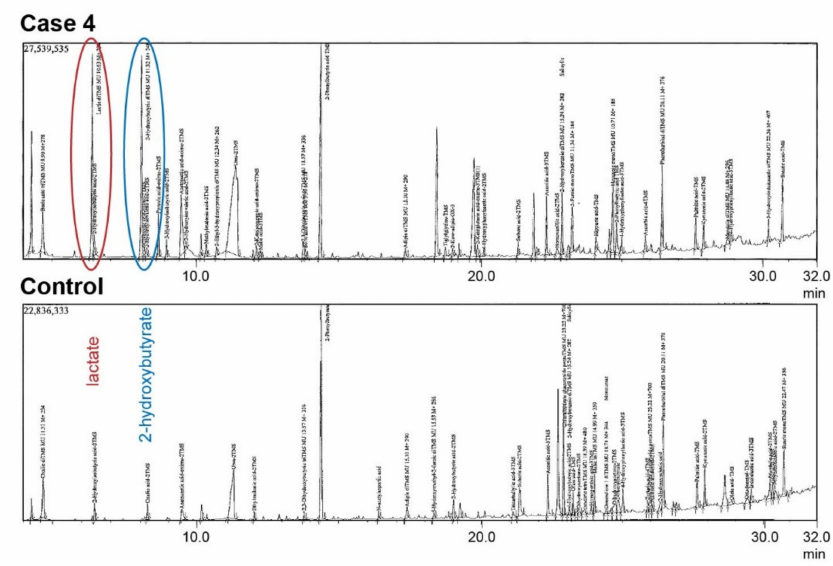
Figure 2. Metabolic screening of urinary organic acids in case 4. Gas chromatographic examination of a 3-year-old paroxysmal exercise-induced dyskinesia (PED)-a ff ected dog’s urine showed an increased excretion of lactate (red circle) and 2-hydroxybutyrate (blue circle) compared to a healthy control